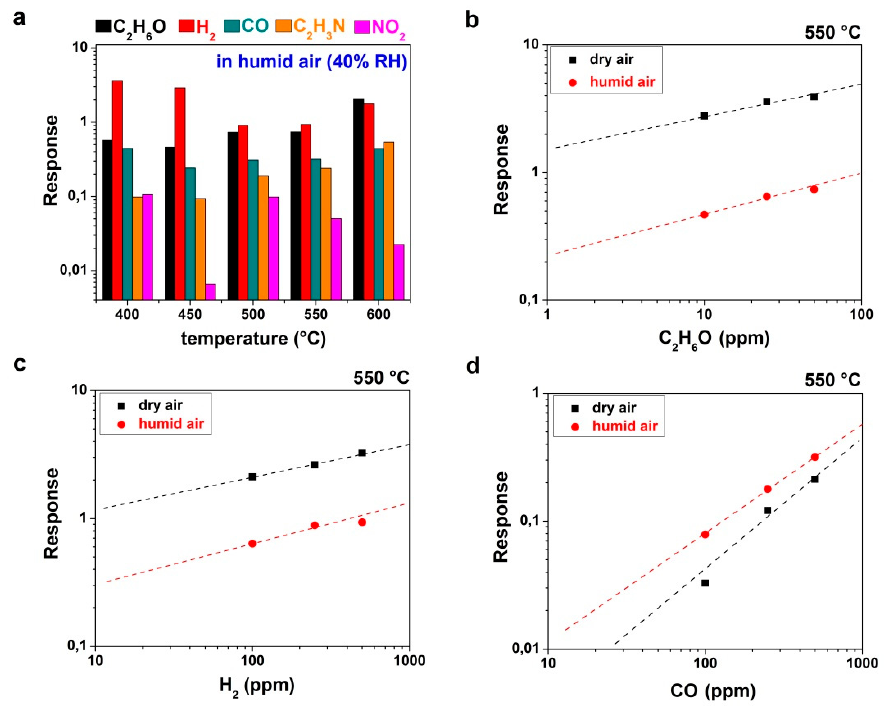
Figure 6. ( a ) Comparison of sensor responses at elevated working temperatures towards 50 ppm C 2 H 6 O, 500 ppm H 2 , 500 ppm CO, 25 ppm C 2 H 3 N, 10 ppm NO 2 gases in humid air (40% RH) atmospheres. Logarithmic response values vs selected concentrations of ( b ) ethanol, ( c ) hydrogen, and ( d ) carbon monoxide.